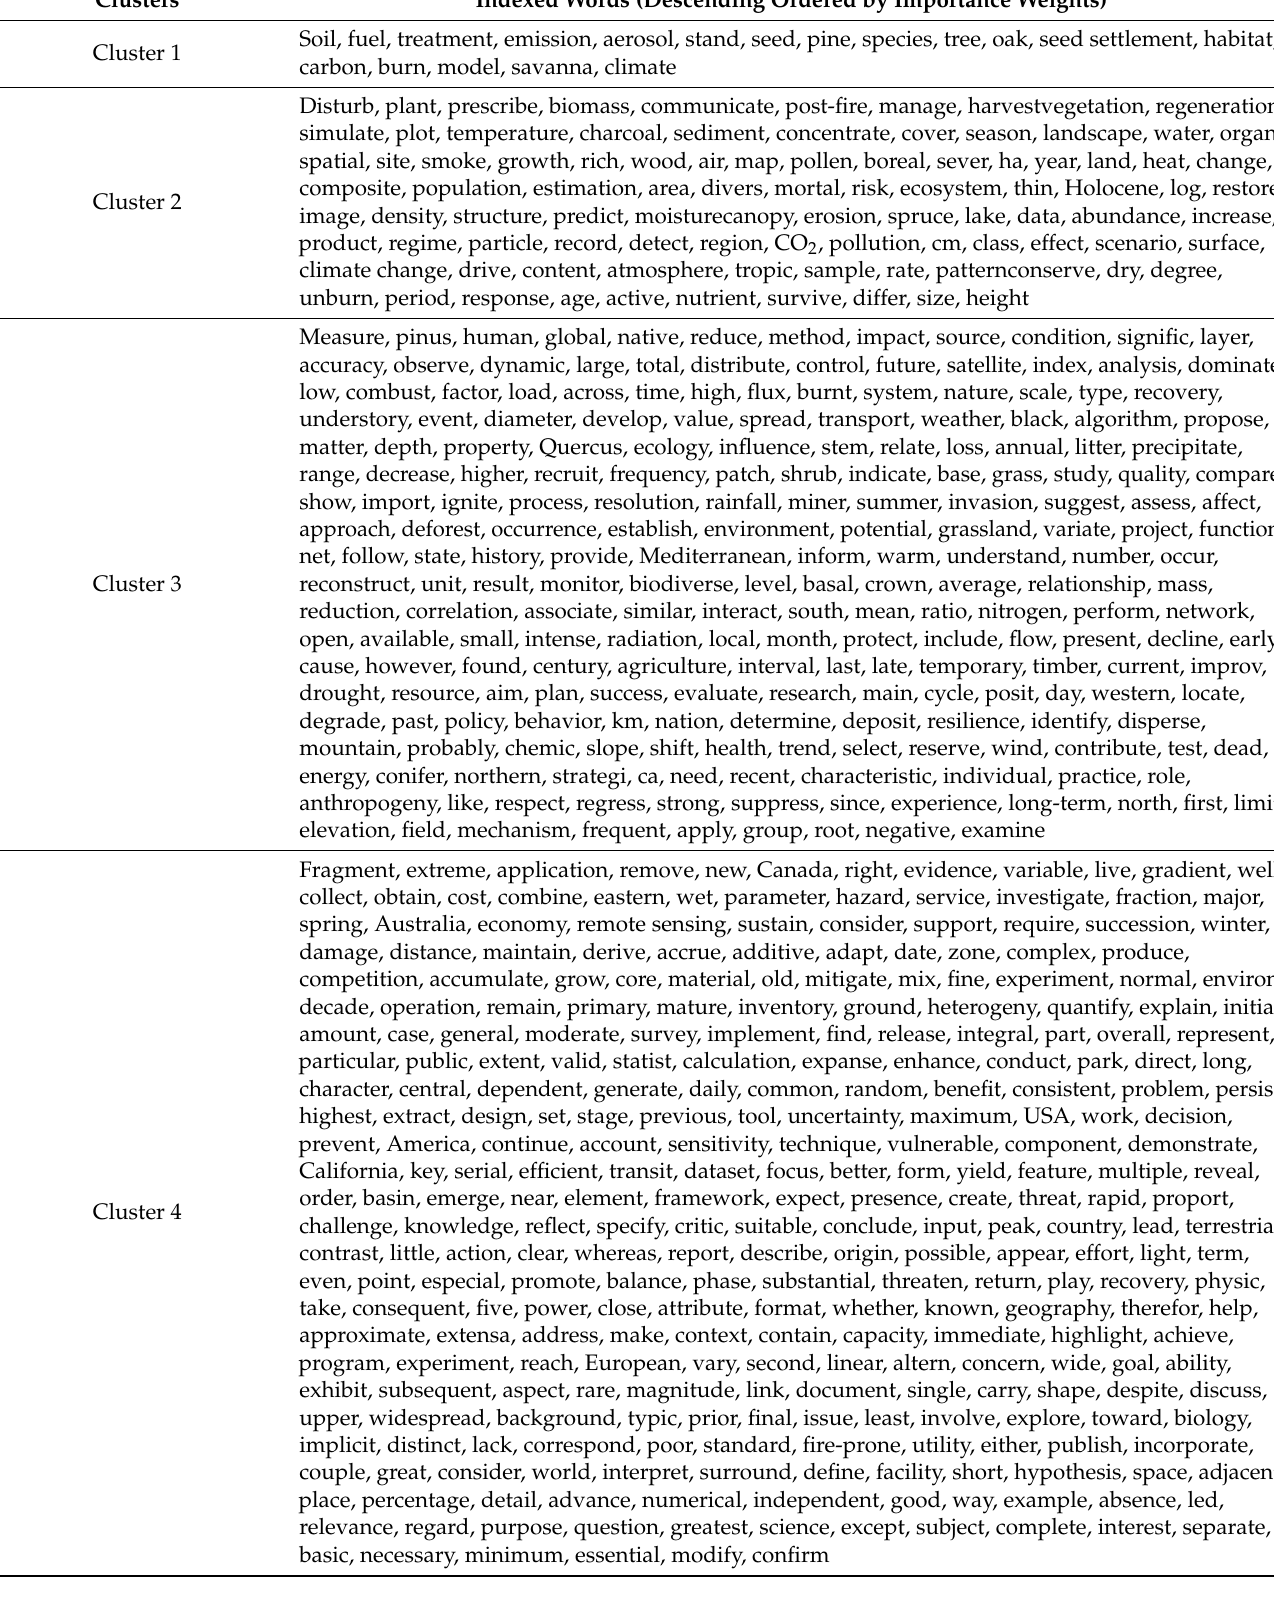
Table 6. Clusters’ memberships of indexed words via importance